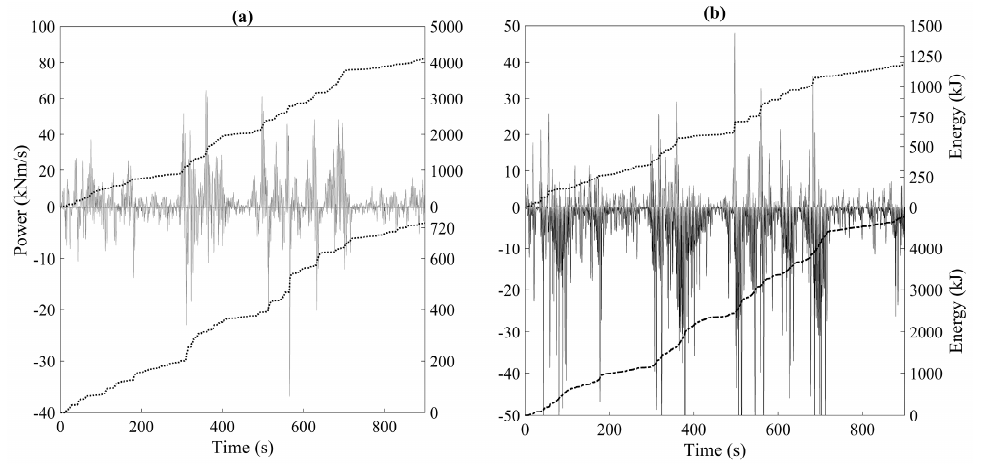
Figure 14. Power and its time integral (dotted line) energy for ( a ) ATMD; and ( b ) SHMD configuration. Positive stands for energy addition and negative for energy dissipation.